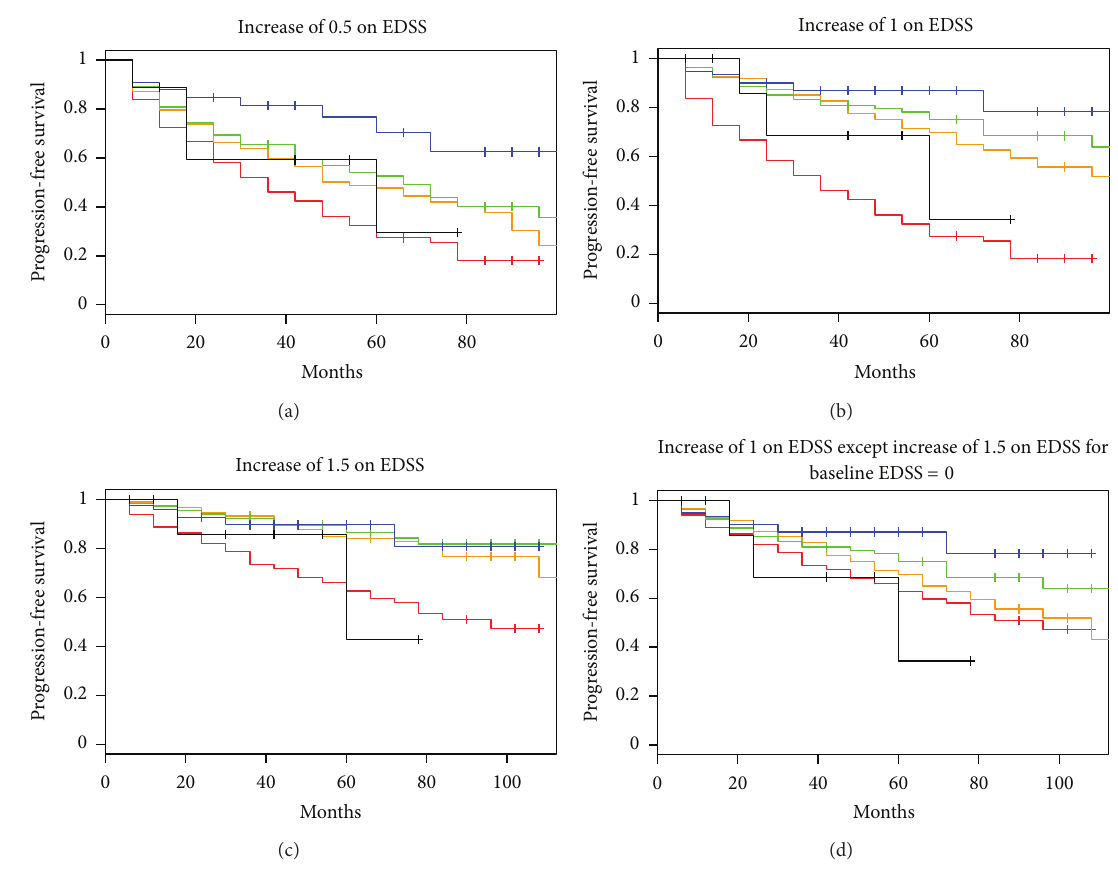
Figure 4: Time to sustained progression stratified by baseline EDSS value. Colors of Kaplan-Meier curve are based on baseline EDSS value: EDSS = 0: red, EDSS = 1/1.5: orange, EDSS = 2/2.5: green, EDSS = 3/3.5: blue, EDSS = 4–5.5: black. Progression definition for each plot: (a) D1, (b) D2, (c) D3, and (d)